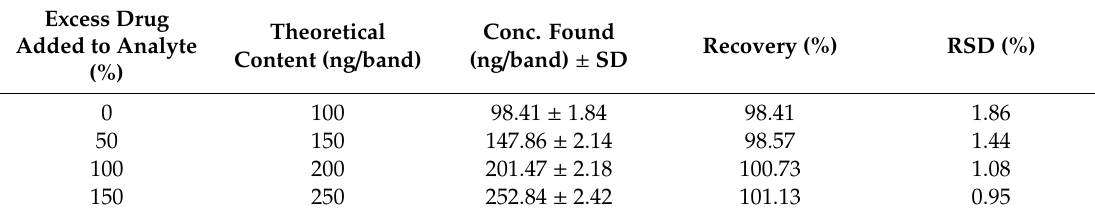
Table 2. Accuracy results of a green reversed phase high-performance thin layer chromatography